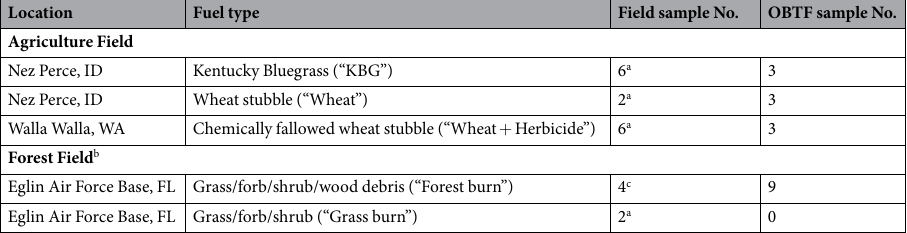
Table 1 provides the field location, fuels, and trial population for the pre- scribed burns. Kentucky blue grass residues ( Poa prantensisi L ., “KBG”), wheat stubble ( Triticum aestivum L ., “Wheat”), and chemically fallowed wheat stubble (“Wheat + Herbicide”) were burned in field in the northwestern United States (Nez Perce, ID and Walla Walla, WA). A grass plot consisting of various species of grasses, forbs, and turkey oak ( Quercus laevis ) and a forest plot of primarily long leaf pine ( Pinus palustris ) were burned at a for- est field in the southeastern United States (Eglin Air Force Base, FL). Further description of the prescribed burns is given in supplementary information and Table S1, and Holder et al . 39 exhaustively describe the forest prescribed burning. The sampling methods and instrumentation applied here were identical to those applied previously 16, 33, 39 . Briefly, both ground and aerial (aerostat) sampling with identical instrumentation packages were deployed during the prescribed burns. One instrumentation package, including continuous measurements of CO 2 (LICOR-820, LICOR Bioscience), BC (AE51, Aethlabs) and particle size distribution (DustTrak DRX 8533, TSI), and batch sampling of PM 2.5 (Impactor, SKC) etc., was attached to a helium filled, tethered aerostat (4.3 m in diameter) as the aerial sampling platform; a second instrumentation package was mounted on an all-terrain vehicle as the ground sampling platform. For the duration of each burn, PM 2.5 was sampled at 10 L/min on Teflon TM and quartz